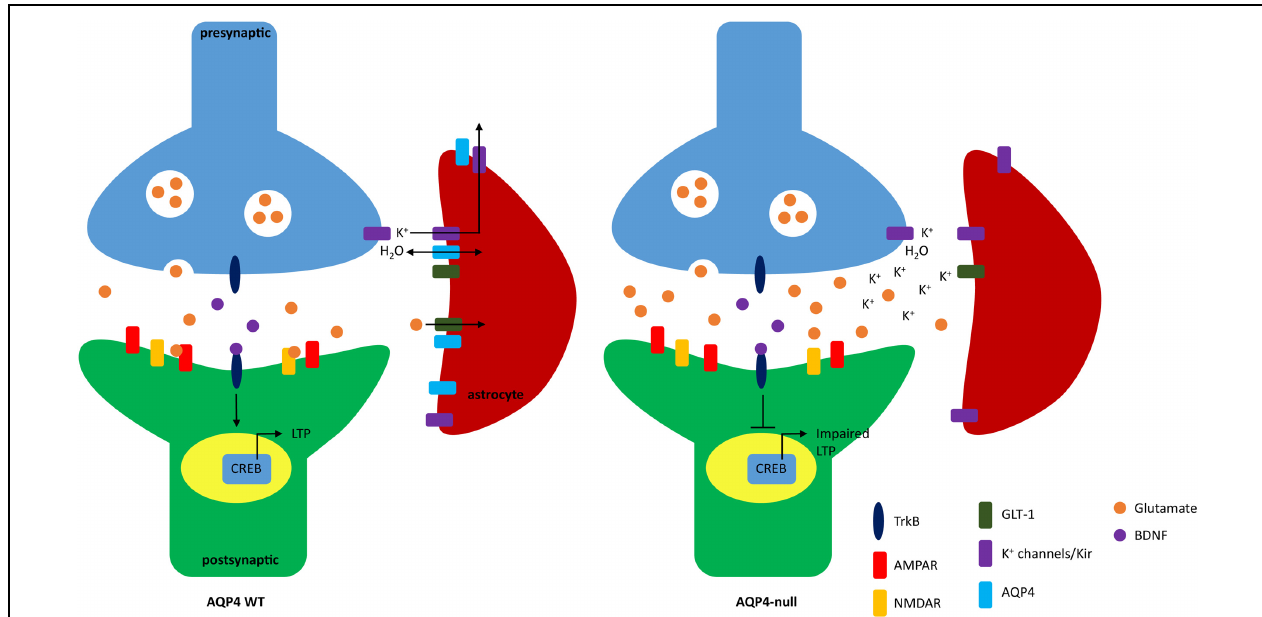
FIGURE 1 | Schematic of impaired long term potentiation (LTP) due to lack of AQP4. In WT mice, AQP4 facilitates the bidirectional transport of water and is seen colocalized with GLT-1 and Kir4.1. Extracellular glutamate and potassium is taken up by GLT-1 and Kir4.1, respectively. Binding of glutamate to NMDA receptor (NMDAR) and AMPA receptors (AMPAR) increases calcium influx and promotes surface expression of AMPAR (not shown). The influx of calcium also modulates brain-derived neurotrophic factor (BDNF). Binding of BDNF to TrkB is regulated through three pathways: PLC γ , PI3K, and MAPK which activates the transcription factor CREB that further promotes gene expression to induce LTP. In AQP4-null animals potassium reuptake in astrocytes is impaired. NMDAR is also dysregulated which may result in loss of calcium influx and ultimately lack of BDNF-TrkB binding which inhibits CREB activation and downstream effects important to synaptic